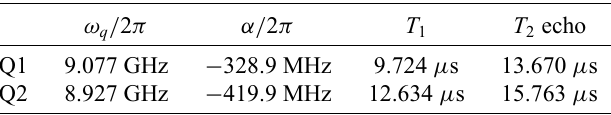
TABLE VII. The parameter fields of the